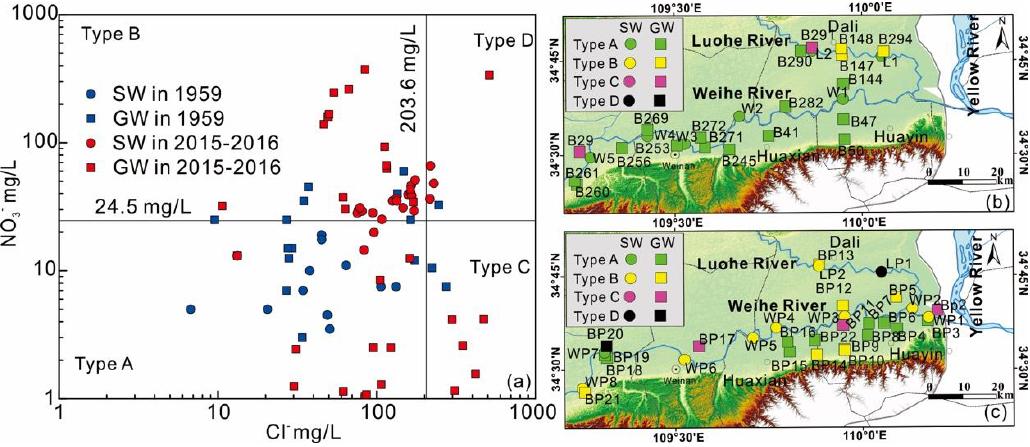
Figure 10. ( a ) Bivariate plot of Cl − vs. NO 3 − for distinguishing water types (points below 1 mg/L are not shown); dominant water types in each sampling site: ( b ) before the dam operation, ( c ) present status. Table 3. Results of water type